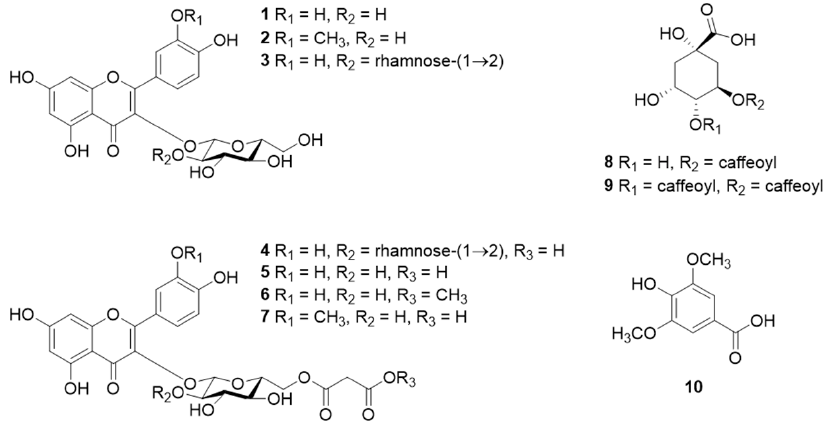
Figure 4. Structures of 1 – 10 .